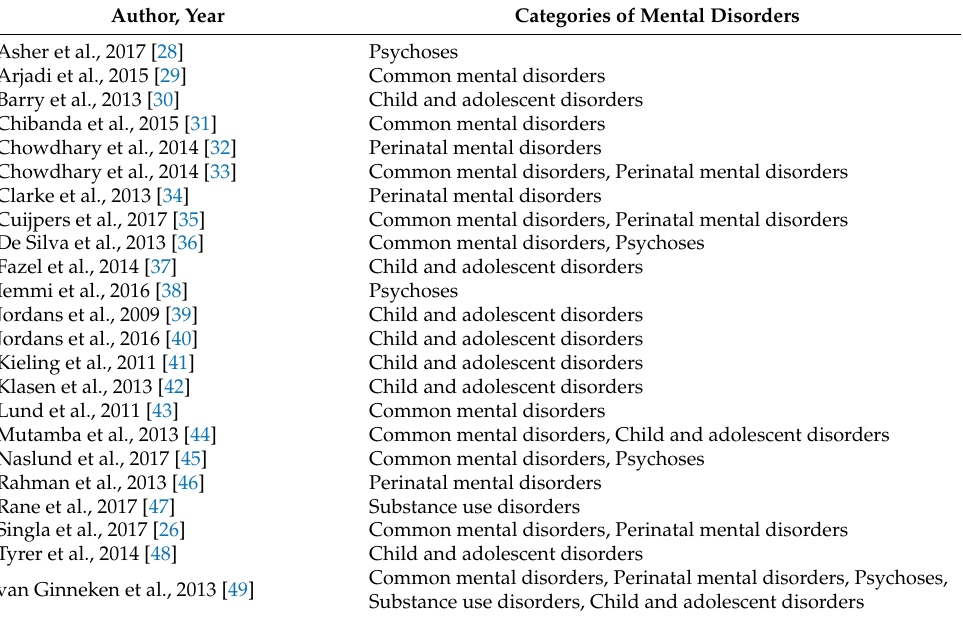
Figure 1. Preferred Reporting Items for Systematic Reviews and Meta-Analyses (PRISMA) Diagram. Table 1. Characteristics of included reviews.